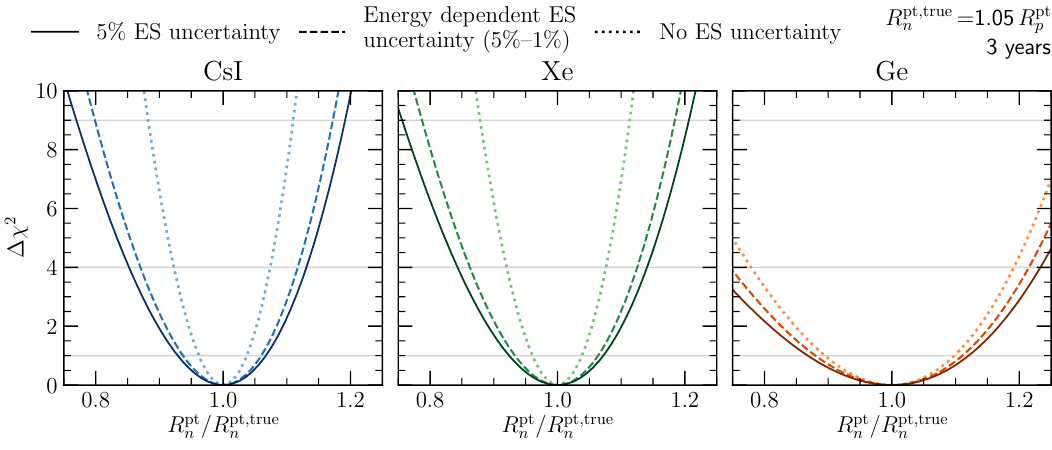
Figure 3 . (cid:1) (cid:31) 2 as a function of the rms radius of the neutron distribution R pt proposed for a CE (cid:23) NS experiment at the ESS: a cryogenic undoped CsI scintillator array (left panel) a high-pressure gaseous xenon chamber (central panel), and a low-threshold, multi-kg p-type point contact germanium detector (right panel). In all cases an exposure of 3 years is assumed, together with a 10% signal normalization uncertainty and a 5% background normalization uncertainty. The three curves in each panel show our results for di(cid:11)erent assumptions for the systematic uncertainty in the energy scale reconstruction: negligible (dotted lines), energy-dependent, varying from 5% at T rec ; th to 1% at T rec ; max (dashed lines), and 5% energy-independent (solid